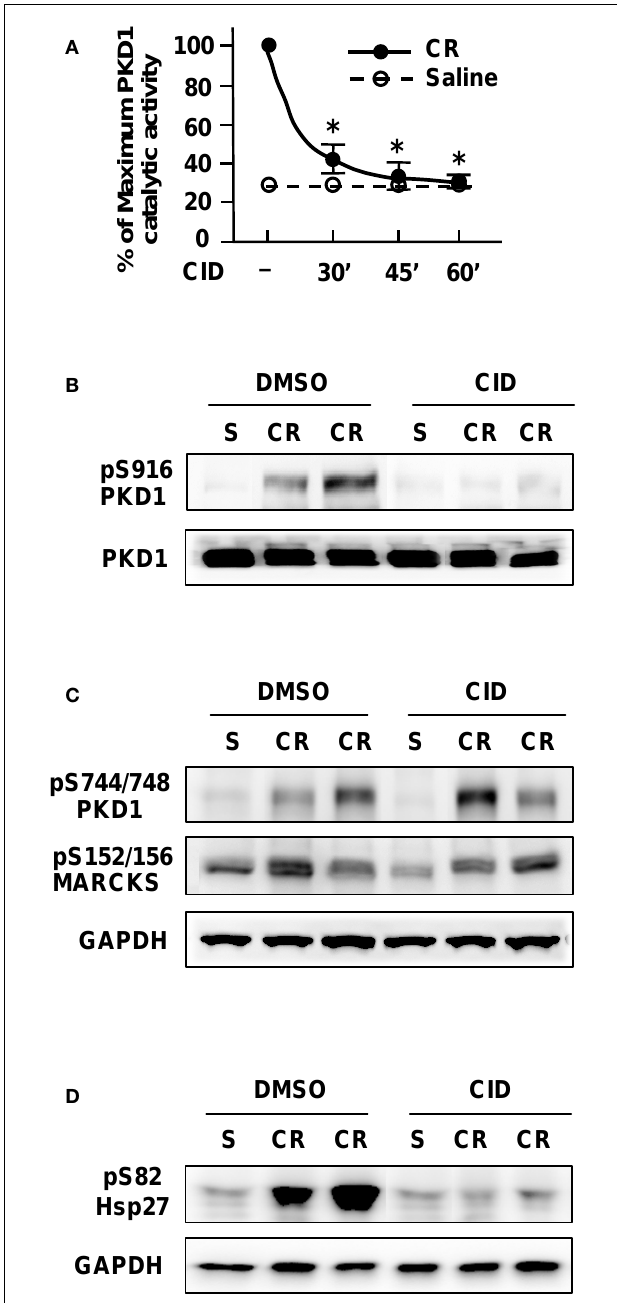
FIGURE 3 | CID755673 pretreatment inhibits PKD/PKD1 activation in pancreatic tissue in cerulein-induced pancreatitis. (A) Rats received intraperitoneal (IP) injection of CID755673 (CID, 15mg/kg) or same volume of vehicle DMSO. After 30, 45, or 60min waiting time, the inhibitor- or vehicle-pretreated animals were given an IP injection of cerulean (CR) or saline (S).The pancreas was collected in 30min after the cerulein or saline injection.The pancreas tissue lysates were immunoprecipitated with PKD/PKD1 C-20 antibody and PKD1 activity in the immunocomplexes was determined by in vitro kinase assay. PKD/PKD1 catalytic activities were expressed as percentage of maximum activity in the animals injected with cerulein without inhibitor pretreatment. Results are means ± SE ( n = 3) for